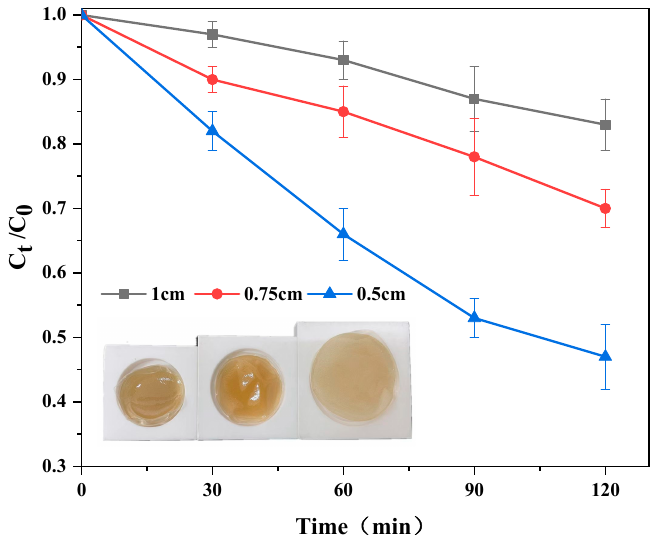
Figure 7. Photocatalytic activity of the PVA/NCD-TiO 2 nanocomposite films fabricated with differ- ent thicknesses for LEV removal under visible light.